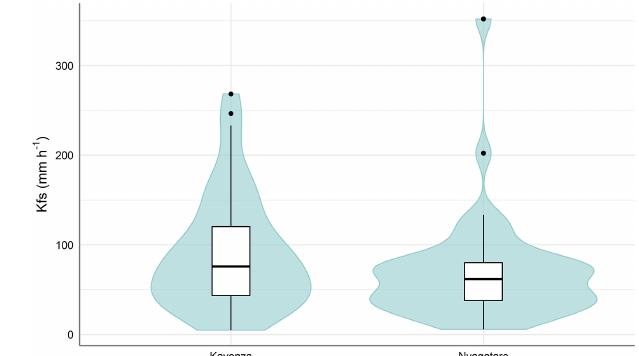
Figure 7. Box and violin plots of field-saturated hydraulic conduc- tivity ( K fs ) for the Kayonza and Nyagatare LDSF sites, Rwanda. The three horizontal lines in the box plot show the lower quartile, the median, and the upper quartile. Whiskers extend to the outer- most data point that falls within 1.5 box lengths. The violin plots show the distribution of the K fs